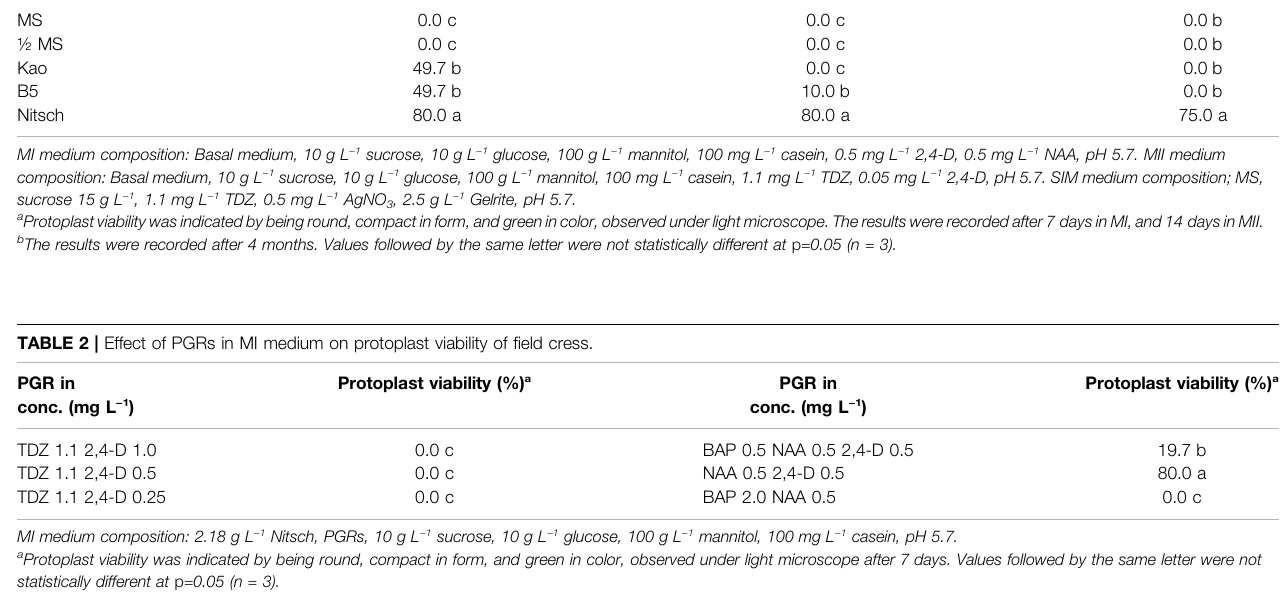
TABLE 3 | Effect of PGRs in MII medium on protoplast callus formation of fi eld cress. PGR in conc. (mg L − 1 )